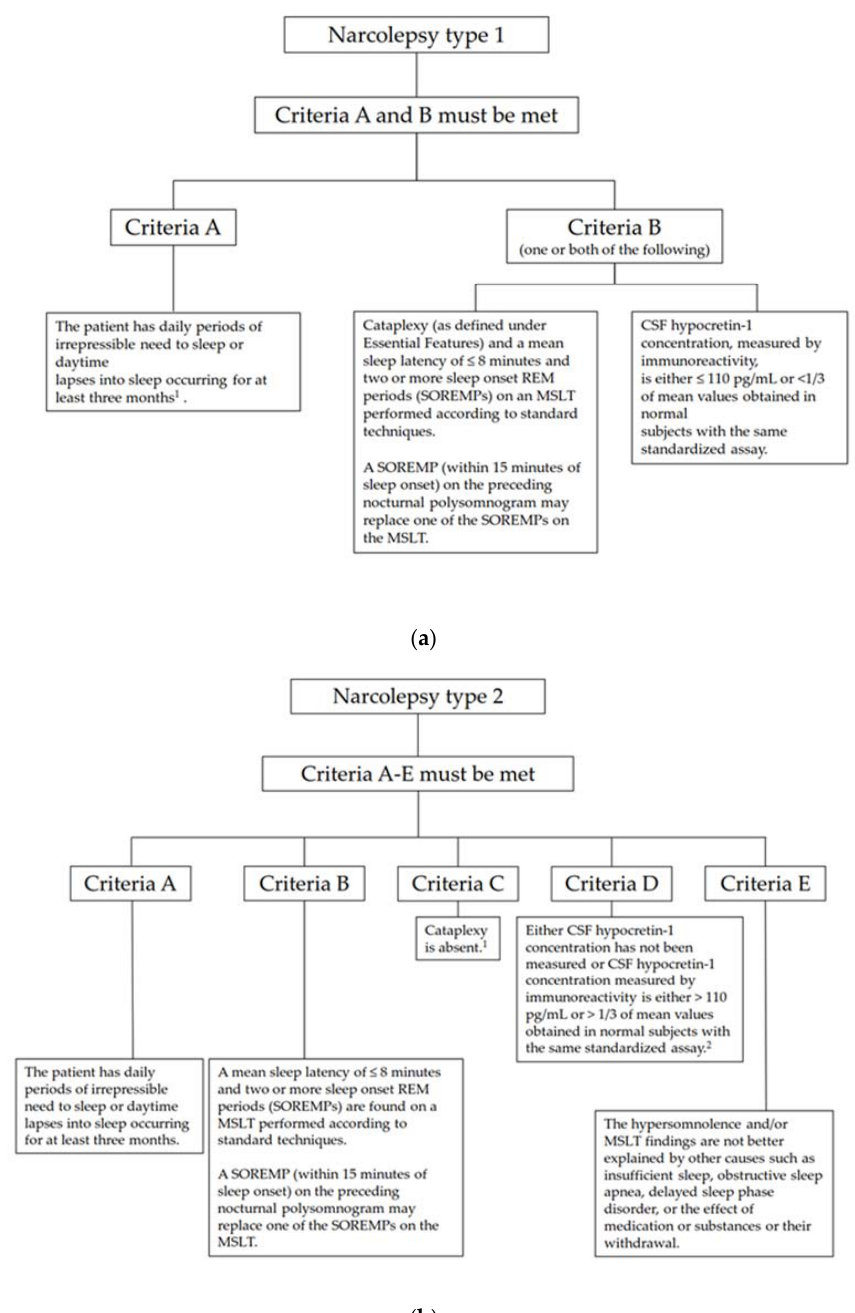
Figure 1. ( a ) Diagnostic criteria of narcolepsy type 1 according to International Classification of Sleep Disorders 3rd ed. [9]. In young children, narcolepsy may sometimes present as excessively long night sleep or as resumption of previously dis-continued daytime napping. Abbreviation: CSF: cerebral spinal fluid, MSLT: multiple sleep latency test, SOREMP: sleep onset rapid eye movement period. ( b ) Diagnostic criteria of narcolepsy type 2 according to International Classification of Sleep Disorders 3rd ed. [9]. If cataplexy develops later, then the disorder should be reclassified as narcolepsy type 1. If the CSF Hcrt-1 concentration is tested at a later stage and found to be either ≤ 110 pg/mL or <1/3 of mean values obtained in normal subjects with the same as-say, then the disorder should be reclassified as narcolepsy type 1. Abbreviation: CSF: cerebral spinal fluid, MSLT: multiple sleep latency test, SOREMP: sleep onset rapid eye movement